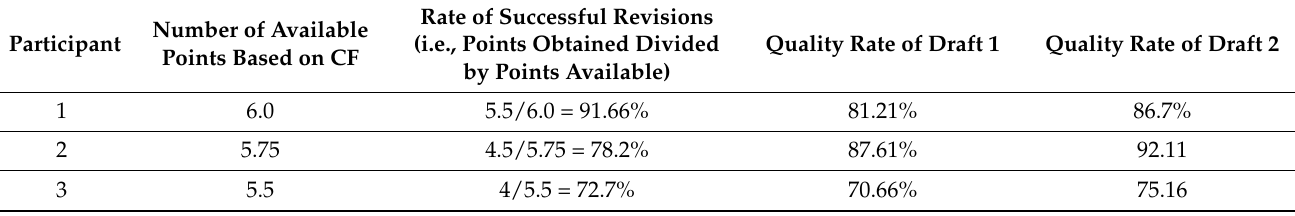
Table 5. Rate of successful revisions and overall text quality of draft 2.